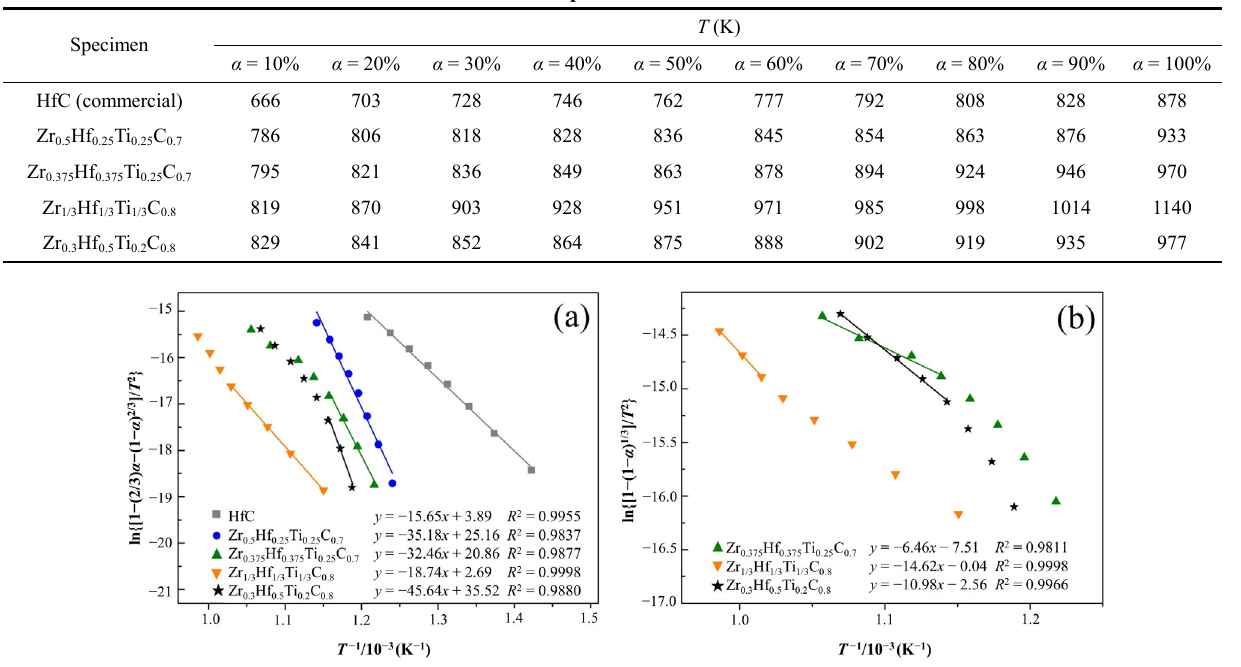
Fig. 12 Activation energy calculations by Coats–Redfern method in the oxidation weight gain process ( α = 0.2–0.9) with (a) G–B model and (b) phase-boundary reaction controlled equation.